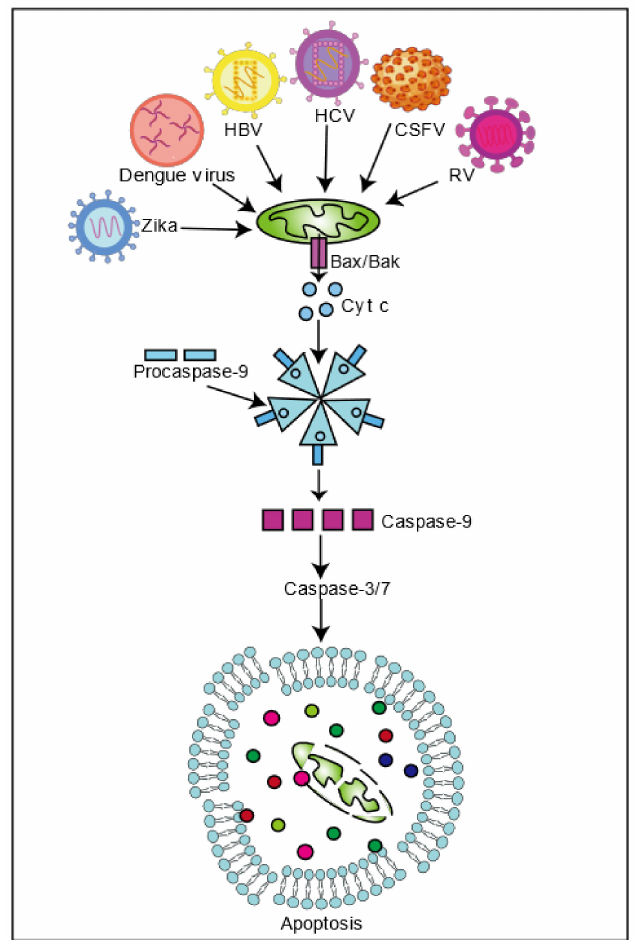
Figure 2. Viral infection regulates mitochondria-induced cell death. Different viruses mediate B-cell lymphoma 2 (Bcl-2) family proteins, release Cyt c, activate procaspase-9, and form apoptosomes, thereby inducing cell